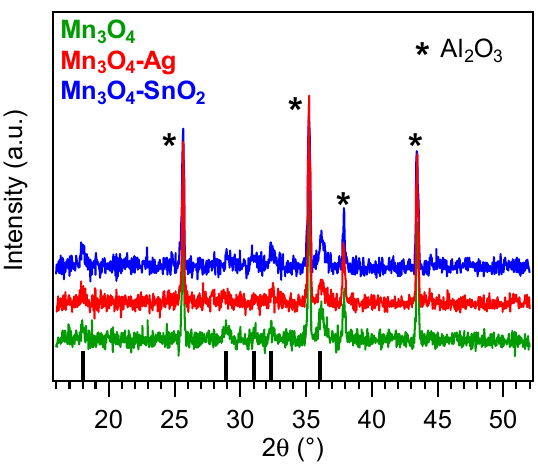
Figure 2. X-ray diffraction (XRD patterns for bare and functionalized Mn 3 O 4 nanosystems. Vertical black bars correspond to α -Mn 3 O 4 signals [59] .